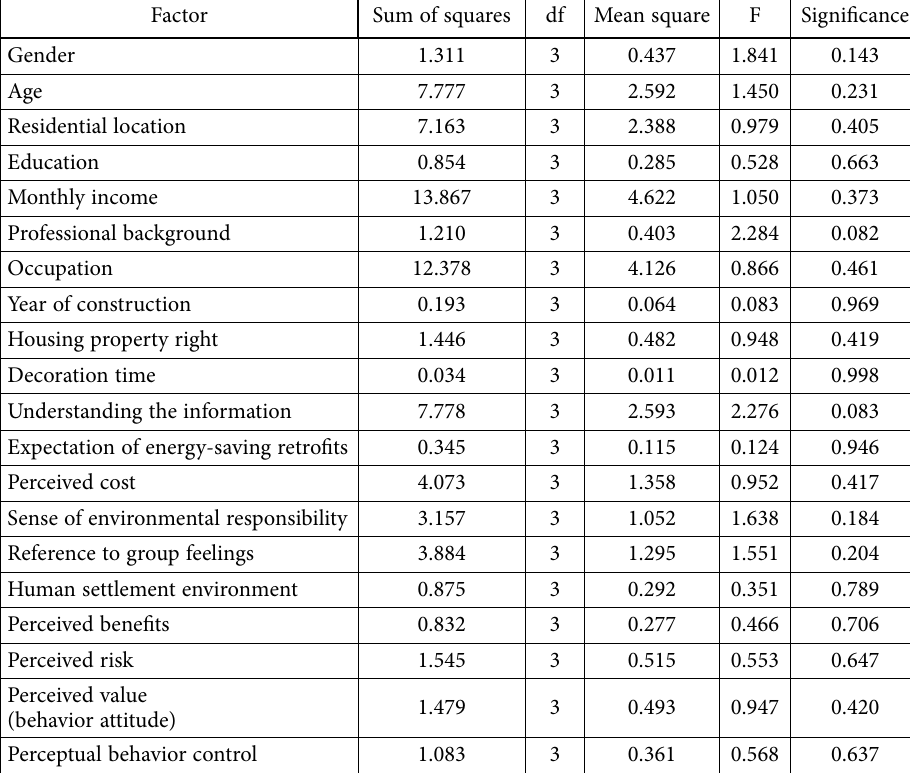
Table 7. Analysis of variance table of WTP and influencing